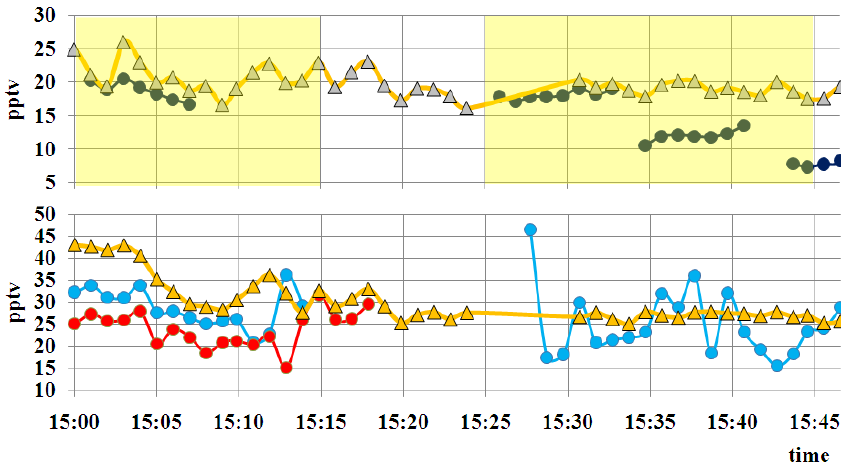
33 Fig. 11. Comparison of model and observations ([HO 2 ] in dark blue, [RO ∗ -DUALER] in blue and [RO ∗ -PeRCA 4] in red) for the 697hPa pressure level during the intercomparison exercise. Model results (triangles) are constrained to j (NO 2 ) measured on board the D-Falcon scaled to the j (NO 2 ) -BAe values measured at 697hPa. The periods of the intercomparison are highlighted in the top figure in yelow. (a) Photolysis